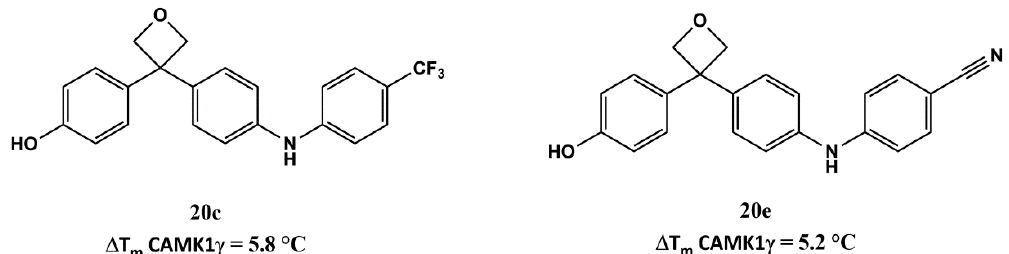
Figure 6. ∆ Tm values obtained for the CAMK1G calcium / calmodulin dependent protein kinase I gamma.